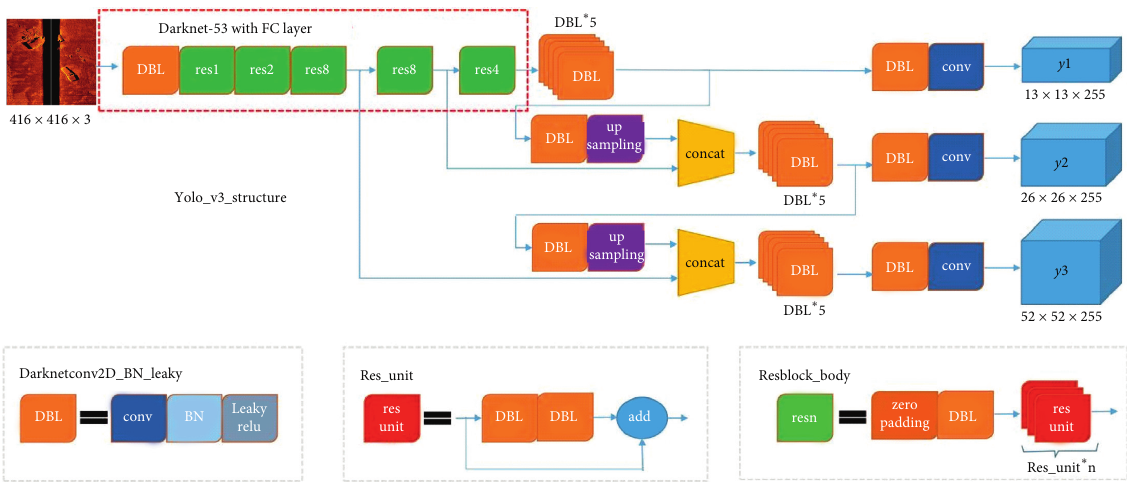
Figure 3: Example diagram of the range of action of a priori box on a substrate texture target.